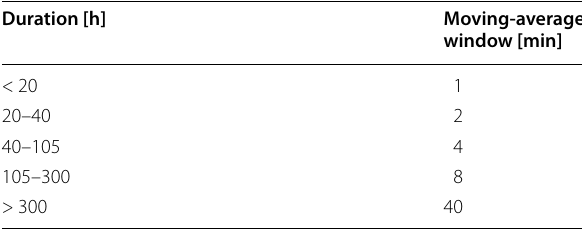
Table 1 Moving-average window applied for different duration